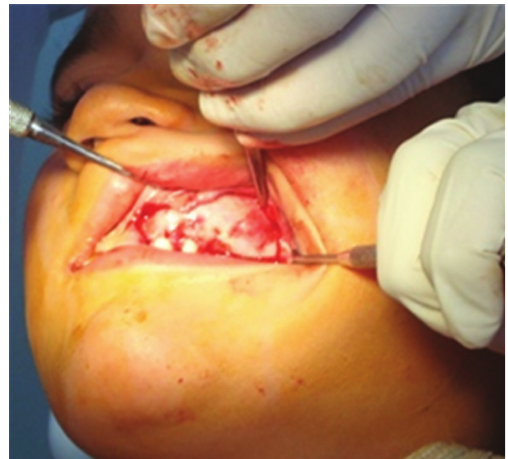
Figure 5: Intraoperative